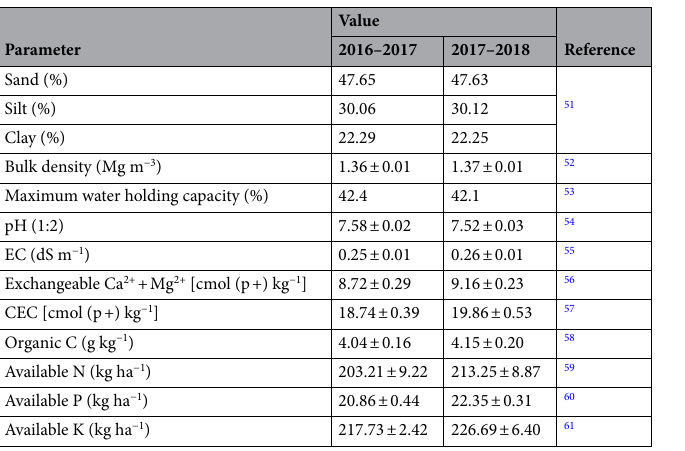
Table 6. Initial properties of the soil before transplanting of crop. Values are ± standard error of